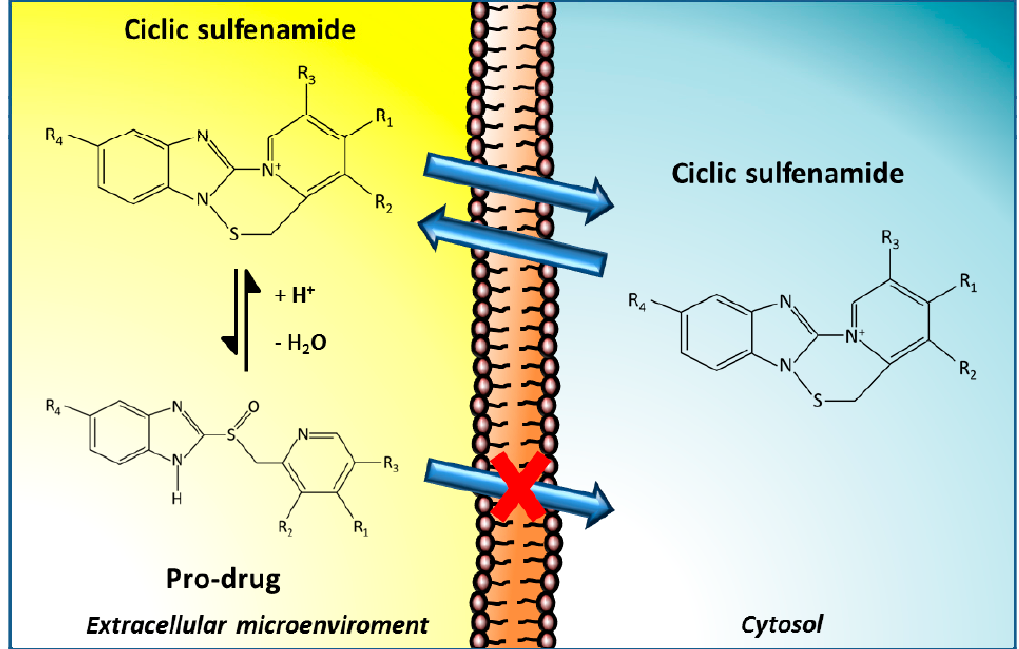
Figure 2. Proton pump inhibitors (PPIs) mechanism of action. PPIs are weak base pro-drugs, that once in the acidic extracellular environment surrounding tumors, can be protonated, thereby reducing their ability to cross the membrane of cells. PPIs then bind irreversibly to proton pumps, dramatically inhibiting their activity, leading to inhibition of proton translocation across the plasma membrane, which in turn, induces alkalization of the tumor microenvironment.